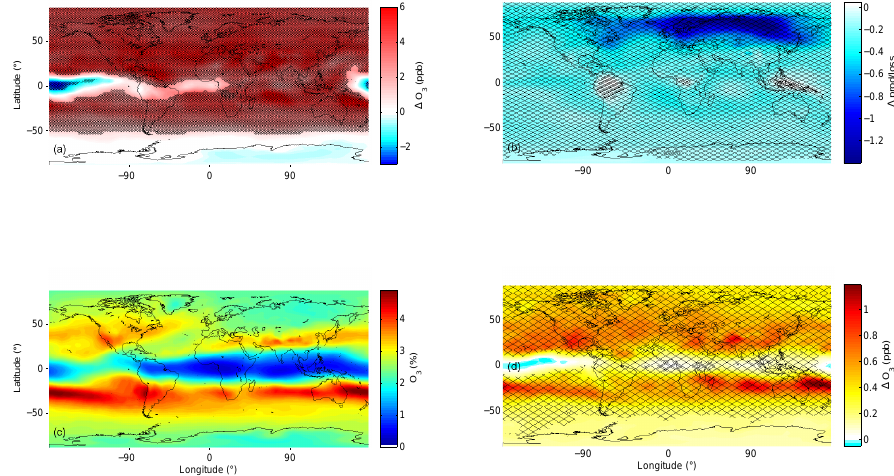
Figure 8. (a) Change in ozone at 500hPa in the fEmis simulation, 2090s minus 1960s; (b) change in the ratio of ozone production over loss in the fEmis simulation, 2090s minus 1960s; (c) percentage of ozone at 500hPa which was produced in the lower stratosphere in the fEmis simulation, 1960s decade; (d) absolute change in the amount of ozone at 500hPa which was produced in the lower stratosphere in the fEmis simulation, 2090s minus 1960s. Shading indicates that the difference is statistically significant at the 95% level of confidence.